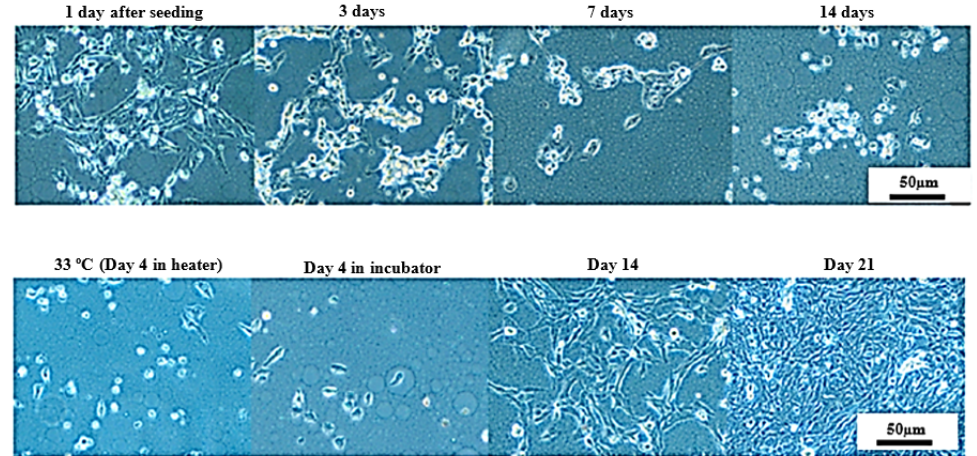
Figure 12. Representative images showing UM-UC-3 cells morphology cultured at room temperature for 14 days (upper panel) and after transfer to the incubator (lower panel).